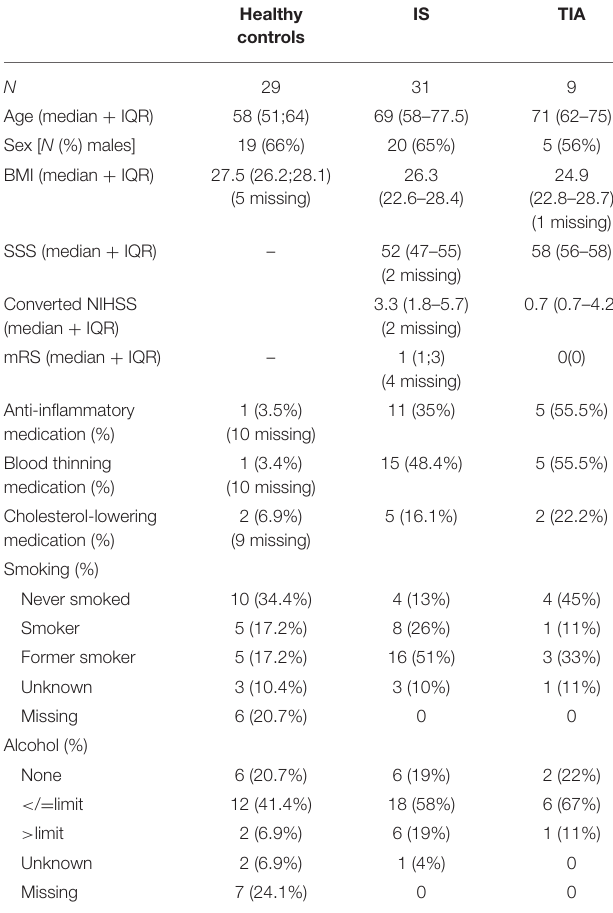
TABLE 1 | Baseline characteristics for healthy controls, ischemic stroke, and transient ischemic attack patients. Healthy controls